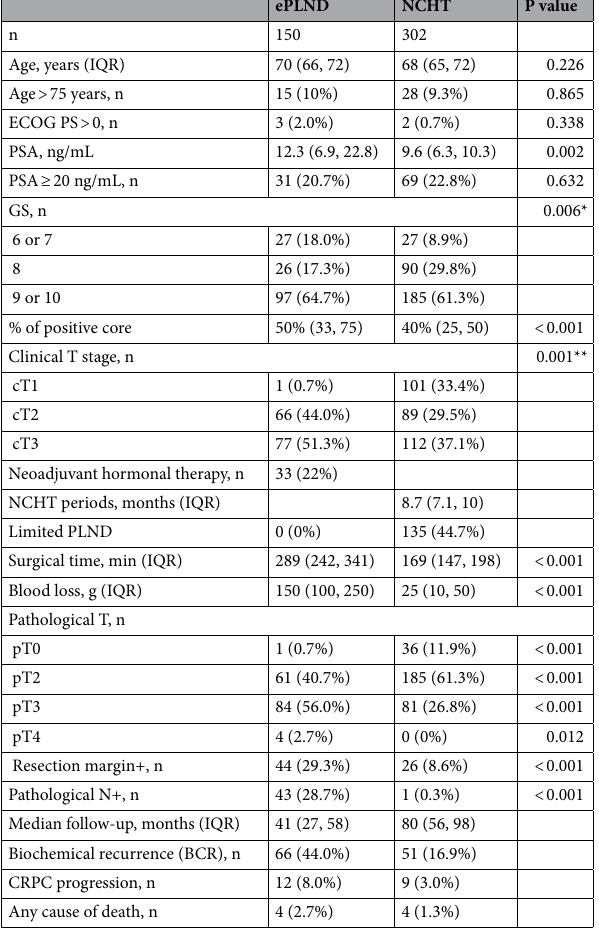
Table 1. Background of patients. PSA prostate-specific antigen, ECOG PS Eastern Cooperative Oncology Group performance status, ePLND extended pelvic lymph node dissection, NCHT neoadjuvant